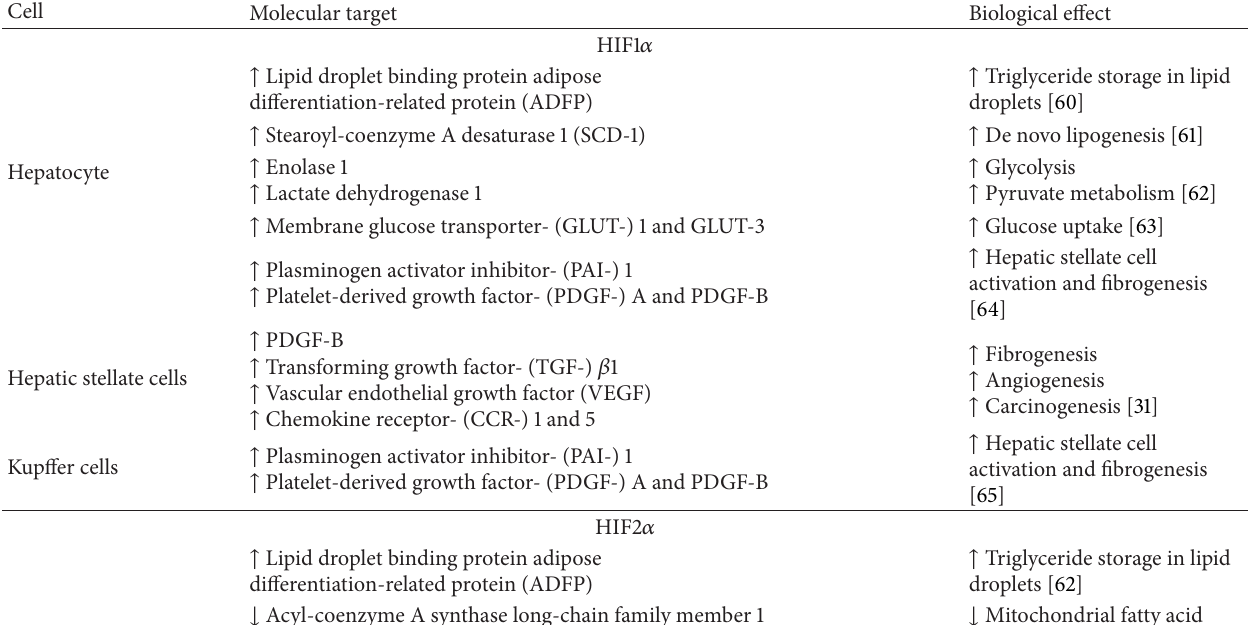
Table 1: Molecular targets and biological effects of hypoxia inducible factors (HIFs) in the